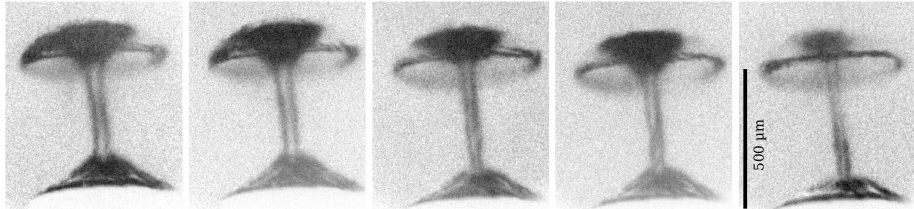
Figure 6. Repeatability of the experiments. Five experimental images from five different recordings of mushroom bubbles at D ∗ ≈ 0 similar to Figure 5, extracted at time instants, where the mushroom shape is thinnest. Background of the images was subtracted. Frame width is 633.5µm ±